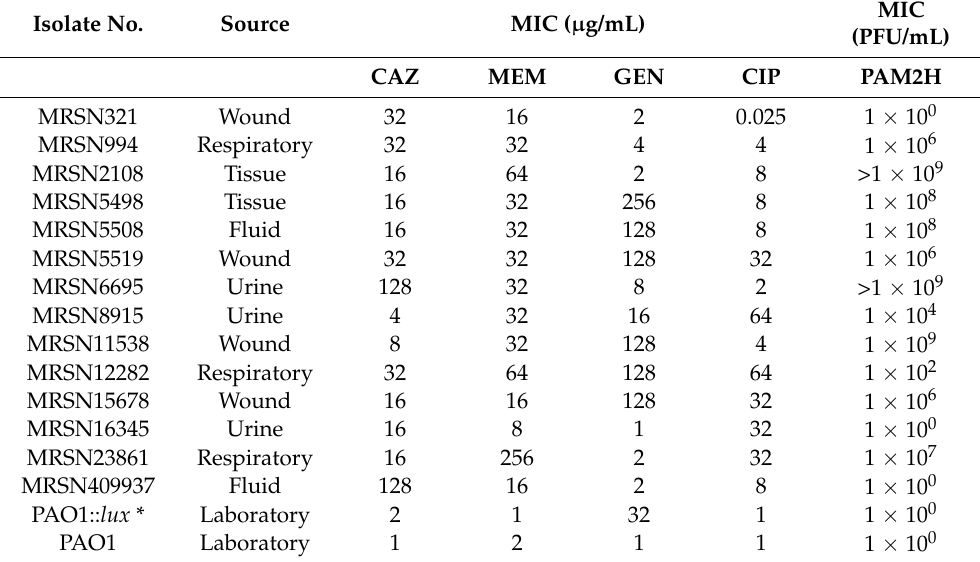
PAO1 Laboratory